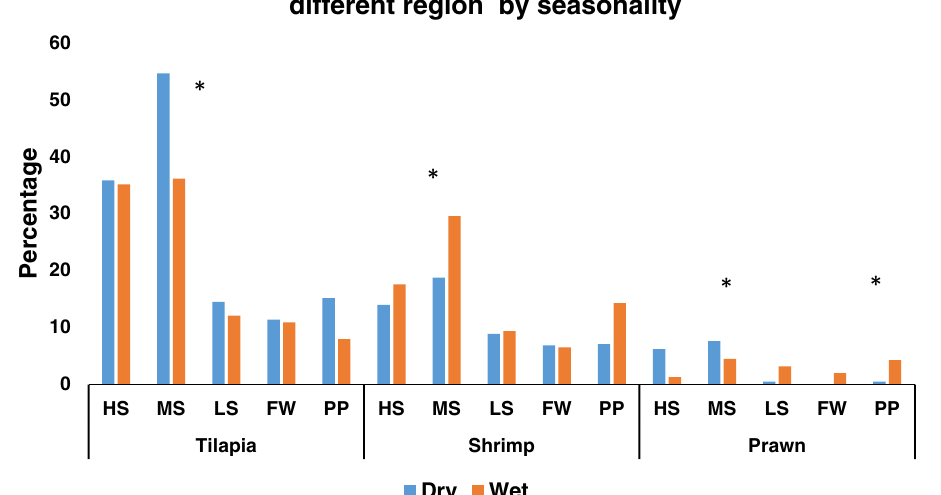
Figure 4. ( A ) Percentage of animal source food consumption, ( B ) Percentage of major types of fish consumed (in last 7 days). Statistical significance ( P < 0.005) has been denoted by asterisk. * Pearson’s chi-square test. Note: Different agro-aquatic ecological zone- HS, High saline; MS, Medium saline; LS, Low saline; FW, Fresh water, and PP, Processing